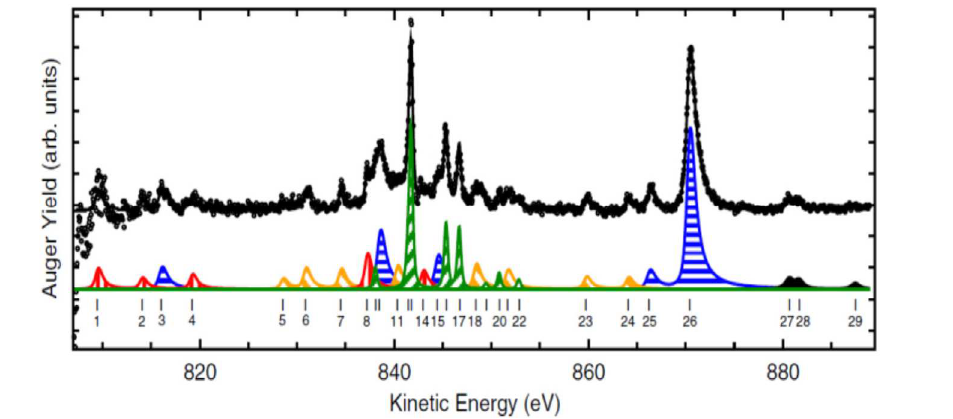
Hypersatellite Auger spectrum of neon.